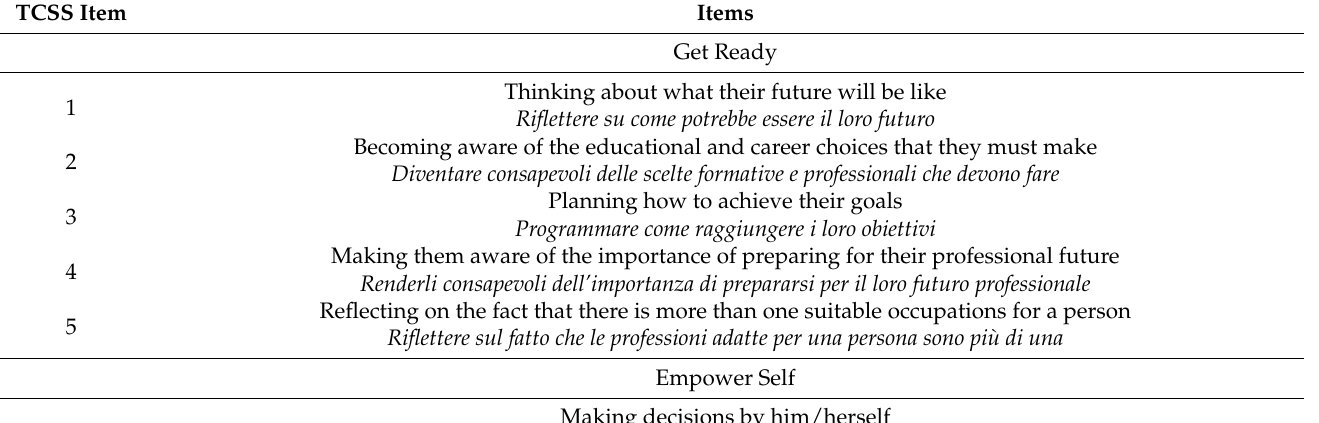
Table A1. Items of the Teacher Career-Related Support Self-Efficacy (TCSSE) in English and Italian (in Italics)